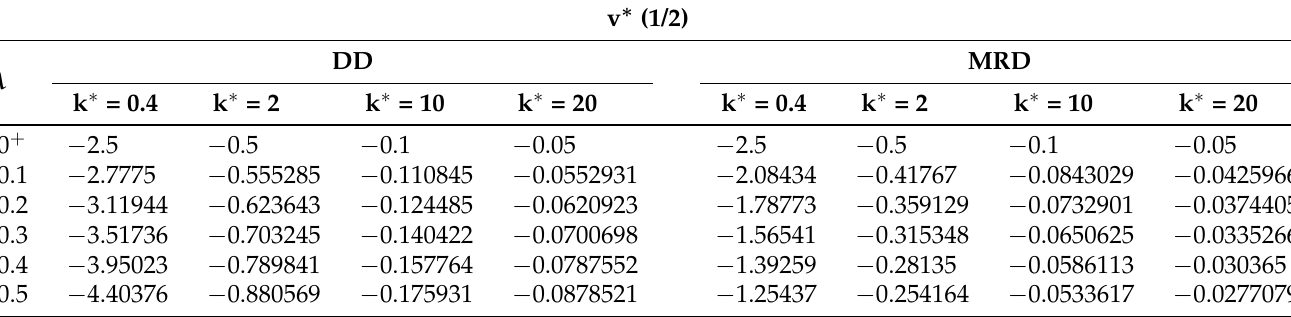
Table 1. Free beam subjected to a non-dimensional uniform load q ∗ y = − 1. Non-dimensional maximum displacement v ∗ ( 1/2 ) versus the non-dimensional length-scale parameter λ evaluated by the non-dimensional Winkler parameter k ∗ ∈ { 0.4,2,10,20 } in the DD and MRD models.